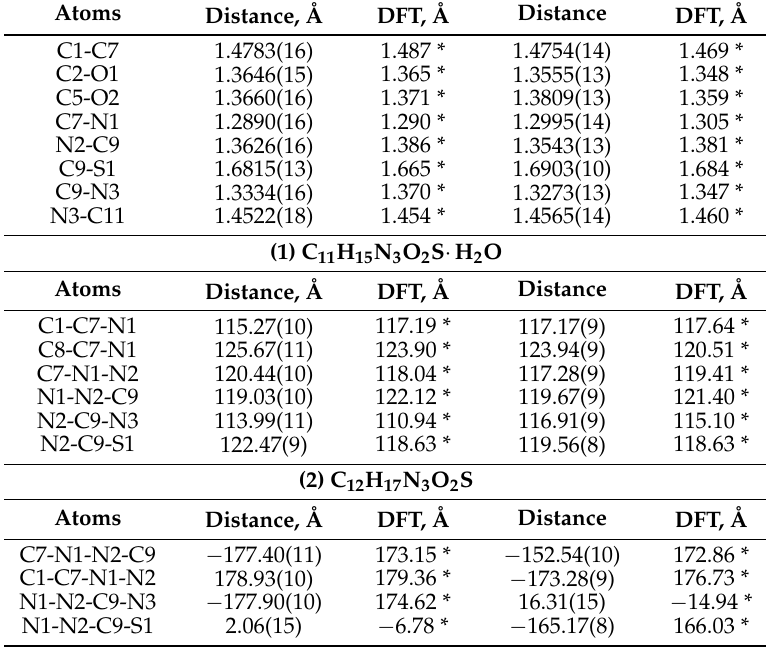
Table 1. Selected crystal and DFT * bond lengths (Å), bond angles ( ˝ ), and torsion angles ( ˝ ): ( 1 )–( 2 ).